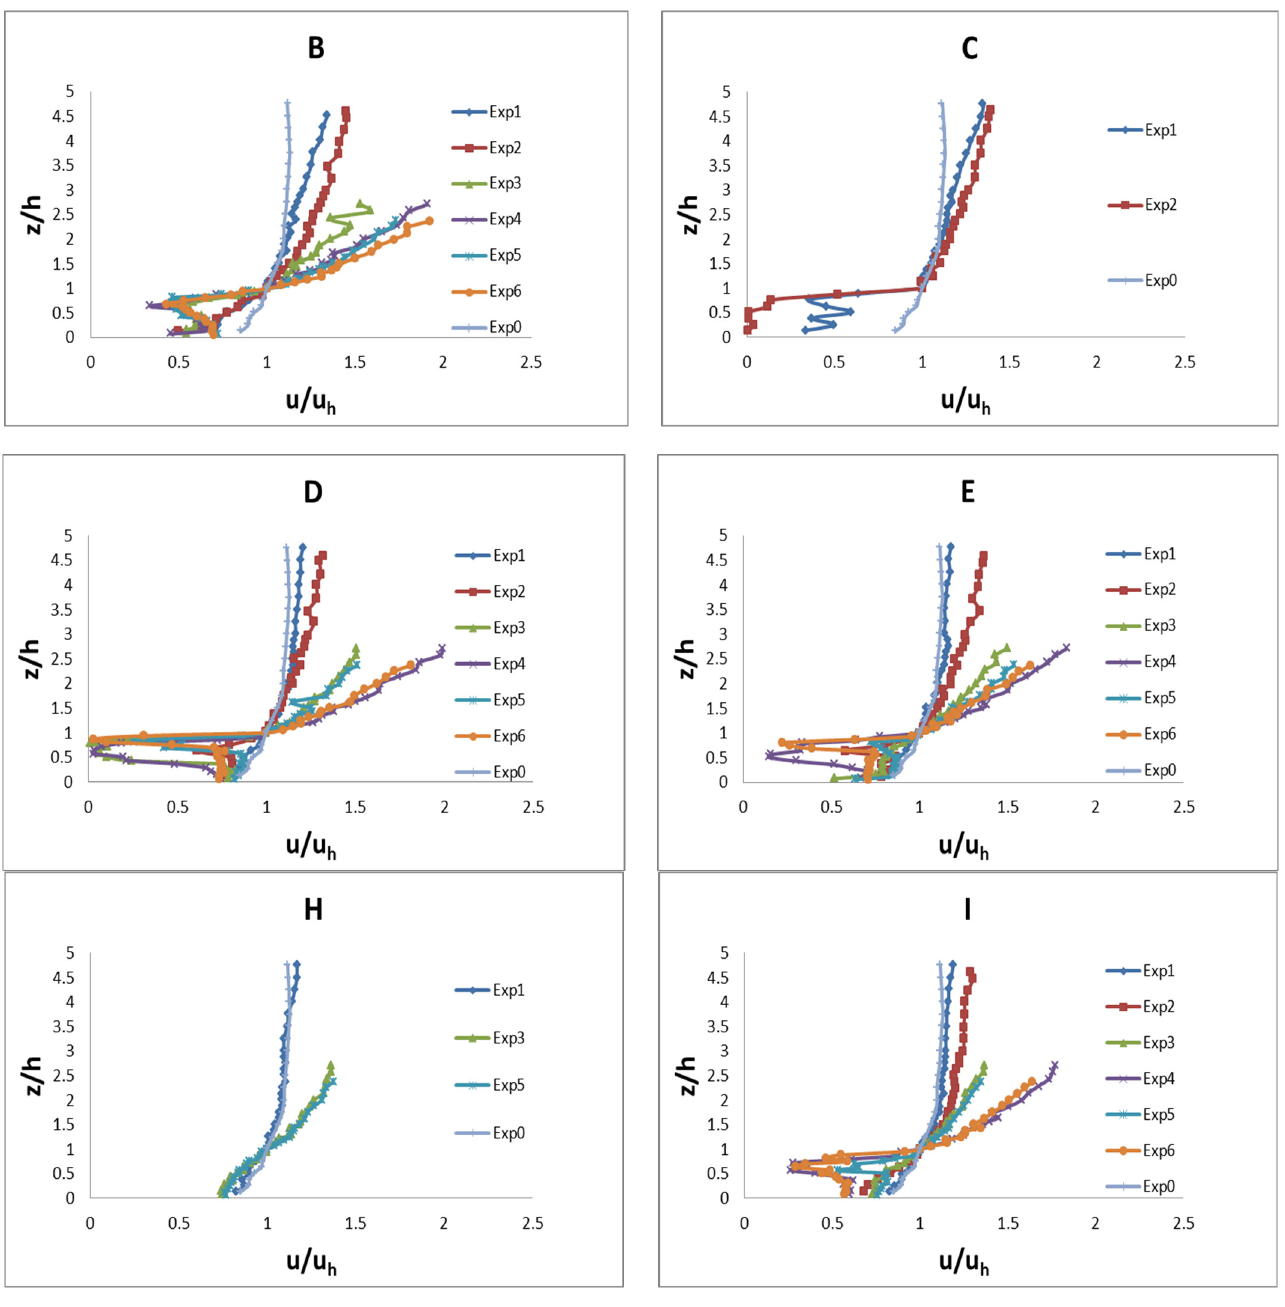
Figure 4. Normalized velocity profiles at locations: B, C, D, E, H and I.